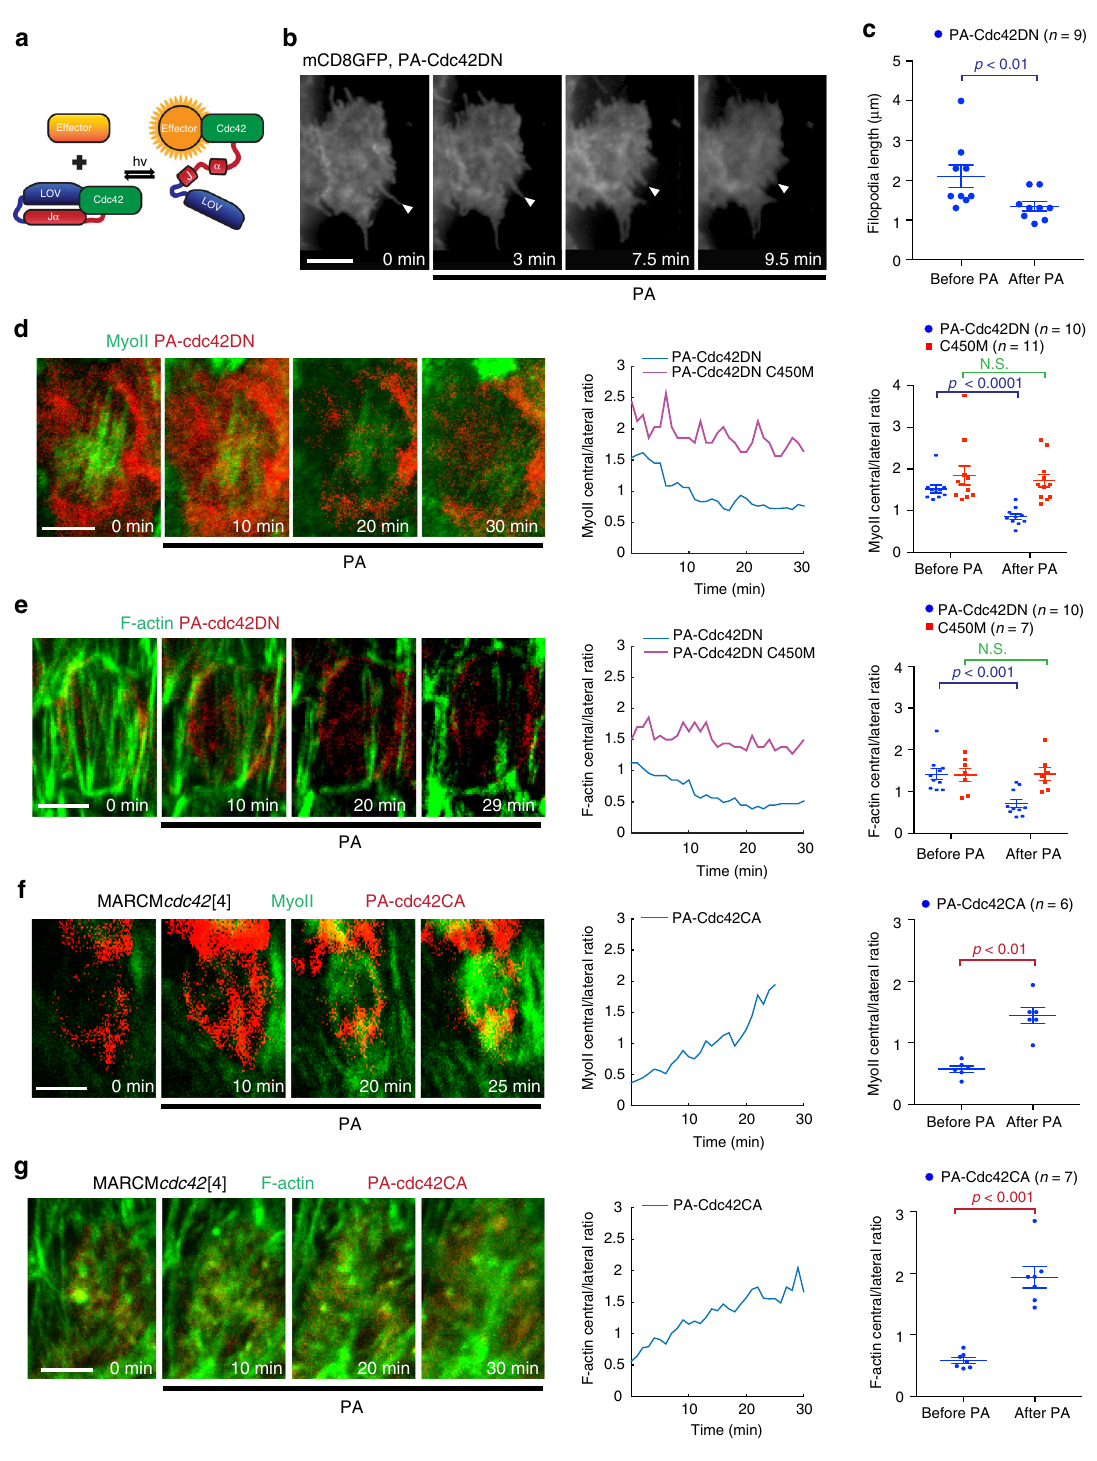
Discussion . Previous studies have shown that subcellular acto- myosin oscillations play a key role in egg chamber elongation. Here, we extend this by directly probing subcellular mechanics and by showing how cellular forces are integrated at the tissue scale to drive tissue extension. A supracellular and DV-polarized F-actin network emerges from interdigitating fi lopodia that penetrate actomyosin stress fi bers of neighboring cells. Filopodia are formed by F-actin bundles which radiate from the medial- basal network. Both fi lopodia and actomyosin stress fi bers are under the control of Cdc42. The cellular actomyosin stress fi bers